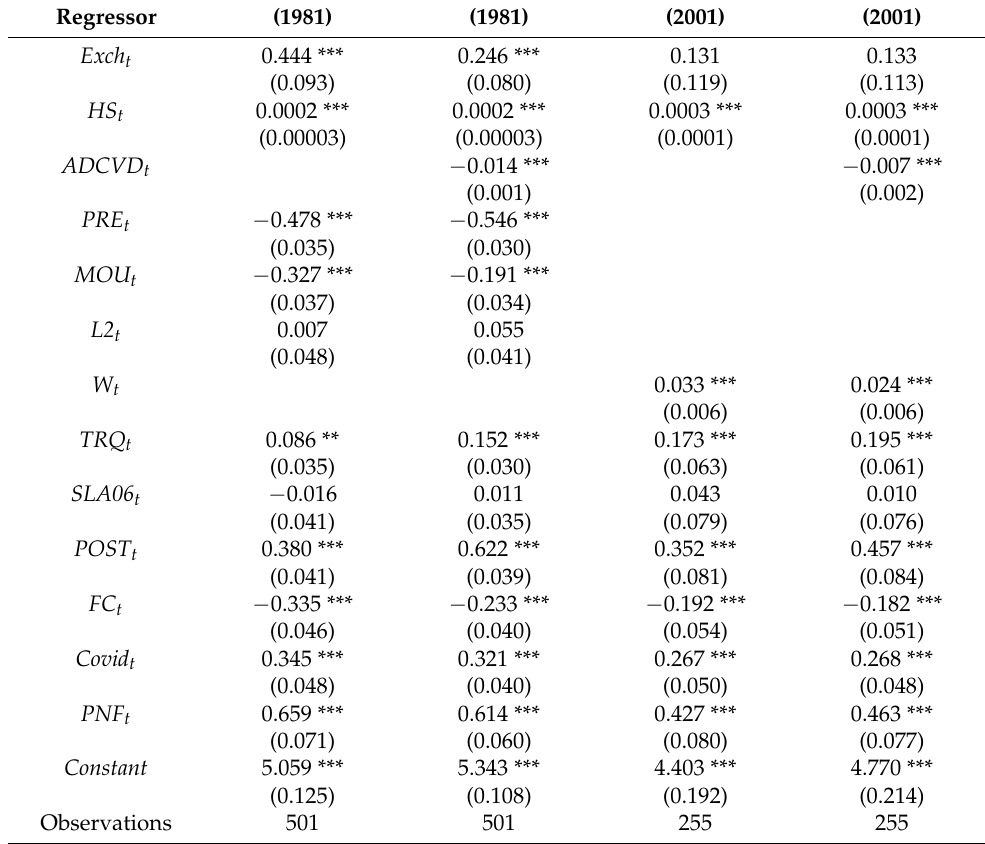
Table A1. Explaining North American Lumber Price Movements: Dependent Variable Logarithm of Spruce-Pine-Fir (SPF) Price